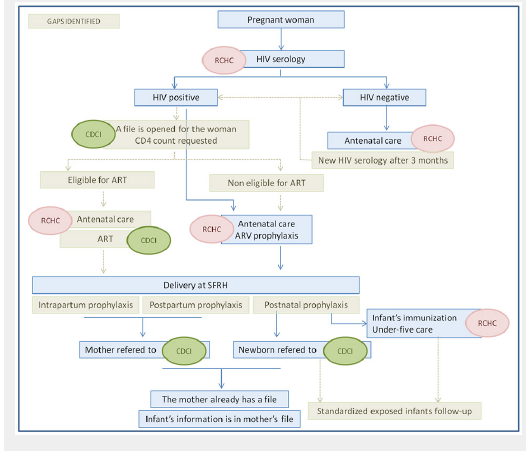
Main gaps identified in the care pathway for prevention of mother- to-child transmission (PMTCT) of human immunodeficiency virus (HIV) at St Francis Referral Hospital (SFRH). The gaps are coloured in brown. RCHC = Reproductive and Child Health Clinic; CDCI = Chronic Disease Clinic of Ifakara; ART = antiretroviral therapy; ARV =